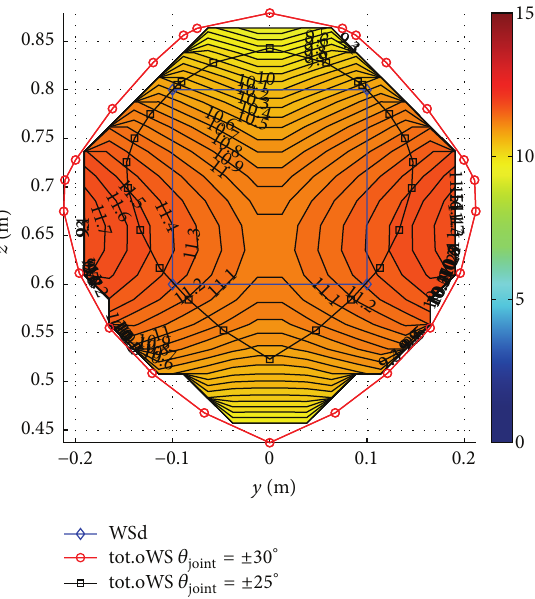
Figure 6: Error of TCP position in 𝑦